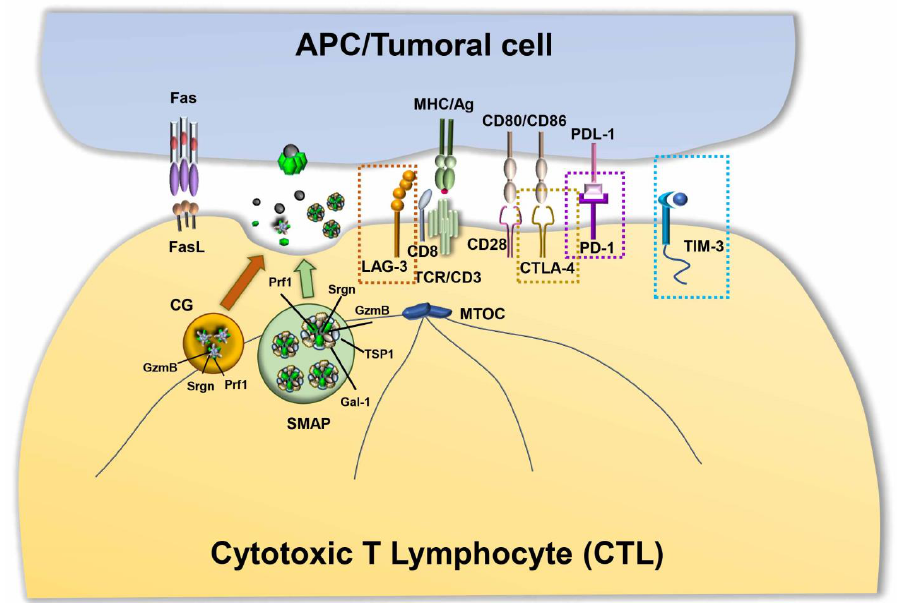
Figure 2. The cytotoxic immune synapse. Upon TCR recognition of tumoral antigens, CD8 + T cells activate cytotoxic mech- anisms to kill target cells. The two classical cytotoxic mechanisms are represented by the release of cytotoxic granules (CGs), with perforin and granzymes released into the synaptic cleft, and the Fas/FasL pathway. Together with these well- characterized mechanisms of cytotoxicity, a new mechanism based on SMAP release contributes to tumoral cell killing. Signals triggered by the inhibitory receptors CTLA-4, PD-1, LAG-3 and TIM-3 antagonize TCR-dependent signaling, caus- ing abnormalities in IS assembly and dysfunctions in the lytic granule transport and release. Although antigen-driven TCR activation in the presence of co-stimulatory signals leads to the generation of CTLs able to effectively kill their specific cell target, in cancer patients, the persistence of tumor-derived antigens gradually dampens CTL functions. Both hot solid tumors and hematologic malignancies show a profound subversion of the complex molecular machinery exploited by CTLs to kill tumoral target cells, a process known as T-cell exhaustion [97]. This functional state, caused by the continuous antigen- driven activation of CD8 + T cells, leads to the upregulation of receptors with inhibitory function, known as immune checkpoints, and to the subsequent subversion of the tight balance between co-stimulatory and inhibitory molecules that controls both the duration and the outcome of the signaling cascade initiated by the TCR (Figure 2). Natural conse- quences of this imbalance are dampened TCR-dependent responses. These include im- paired activation of key TCR-dependent signaling molecules [98–100], abnormalities in IS architecture [99,101,102], and a dysfunctional lytic machinery, with decreased expression of Gzms [103] and impaired cytotoxicity [63]. Furthermore, exhausted T cells in the TME lose their proliferative potential and their ability to produce cytokines, such as IL-2, tumor necrosis factor-alpha (TNF- ), and IFN [97]. Tumor-specific CTLs display hallmarks of T